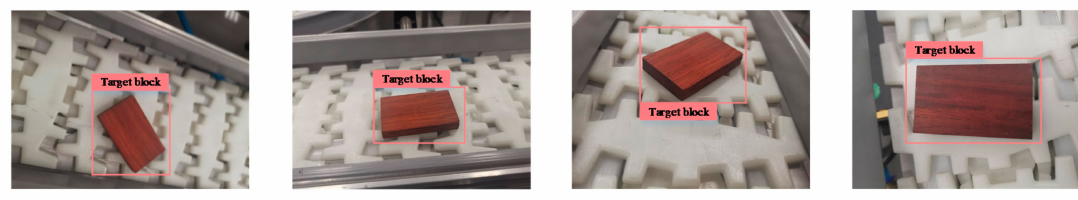
Figure 10. Detection result of the single-target detection.